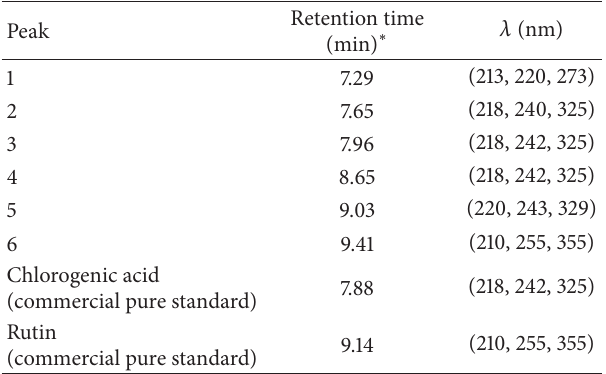
Table 1: Retention times and absorbance values of peaks detected in